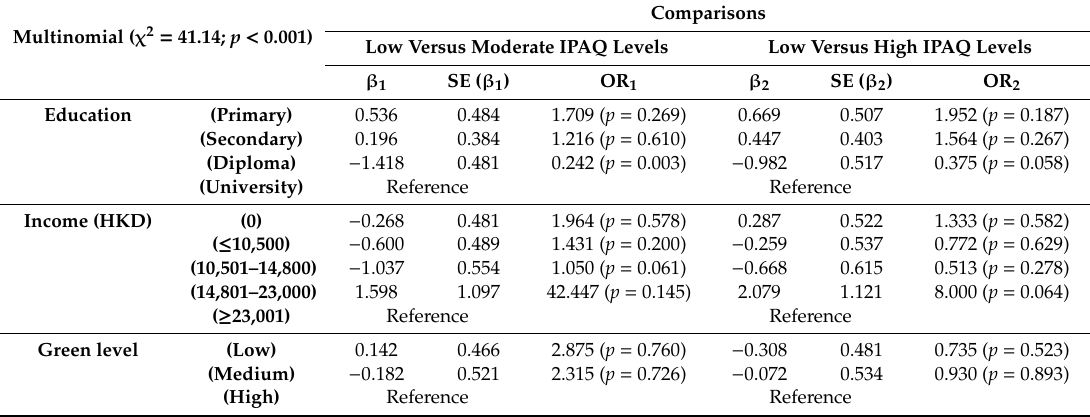
Table 4. Results of multinomial regression analysis using the IPAQ levels as the dependent variable for testing the predictive values of educational levels, individual monthly incomes and green space levels. Multinomial ( χ 2 = 41.14; p < 0.001)